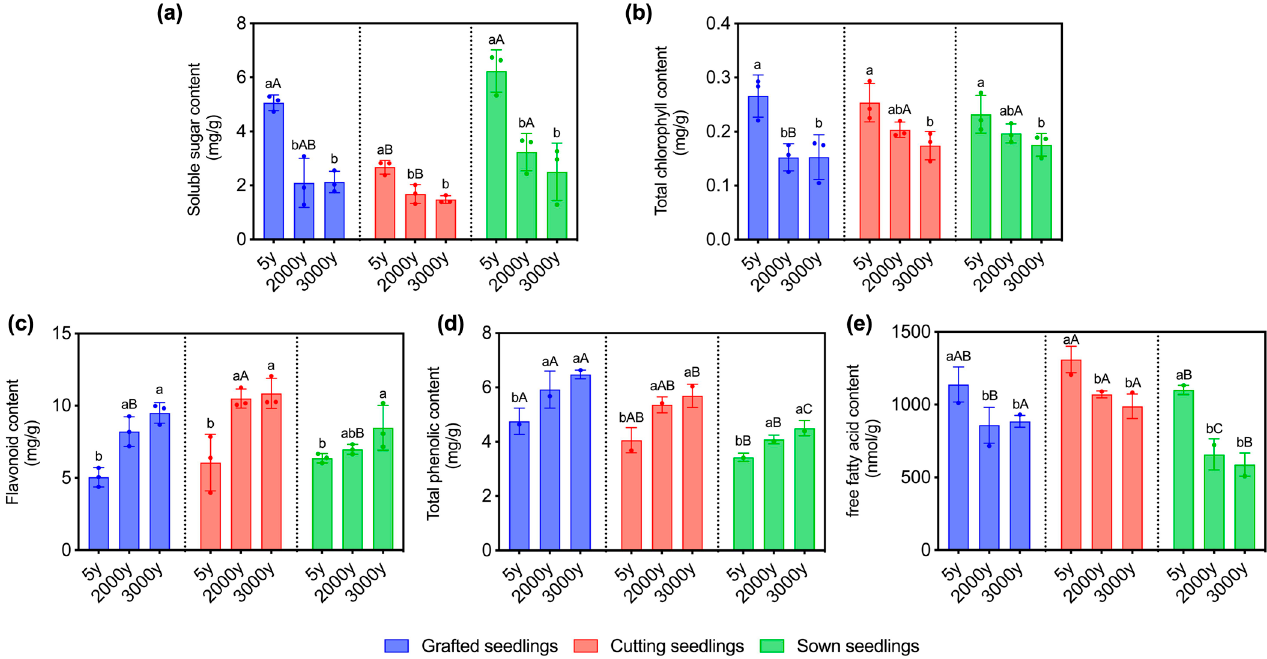
Figure 3. E ff ects of the contents of ( a ) soluble sugar, ( b ) total chlorophyll, ( c ) fl avonoid, ( d ) total Figure 3. Effects of the contents of ( a ) soluble sugar, ( b ) total chlorophyll, ( c ) flavonoid, ( d ) total phenolic, and ( e ) free fa tt y acid in seedlings of P. orientalis propagated from donors at di ff erent ages phenolic, and ( e ) free fatty acid in seedlings of P. orientalis propagated from donors at different ages (5-, (5-, 2000-, and 3000-year-old) in di ff erent methods (seed sowing, cu tt ing, and grafting), respectively 2000-, and 3000-year-old) in different methods (seed sowing, cutting, and grafting), respectively under under low temperature. Le tt ers (a,b) on top of the error bars show the signi fi cance of di ff erences low temperature. Letters (a,b) on top of the error bars show the significance of differences between between seedlings propagated from donors at di ff erent ages (5-, 2000-, and 3000-year-old); Le tt ers seedlings propagated from donors at different ages (5-, 2000-, and 3000-year-old); Letters (A–C) on (A–C) on top of the error bars show the signi fi cance of di ff erences between seedlings propagated in top of the error bars show the significance of differences between seedlings propagated in different di ff erent propagation methods (grafting, cu tt ing and seed sowing). Values are the mean of three replicates of samples, and bars represent standard errors. Means with the di ff erent le tt ers are signif- propagation methods (grafting, cutting and seed sowing). Values are the mean of three replicates icantly di ff erent at p < 0.05 by Duncan’s multiple range test. of samples, and bars represent standard errors. Means with the different letters are significantly different at p < 0.05 by Duncan’s multiple range